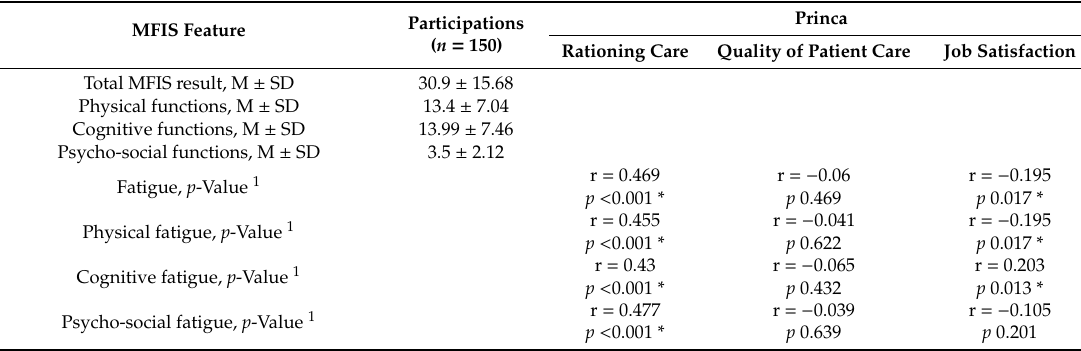
Table 3. Modified Fatigue Impact Scale (MFIS) compared with the rationing of nursing